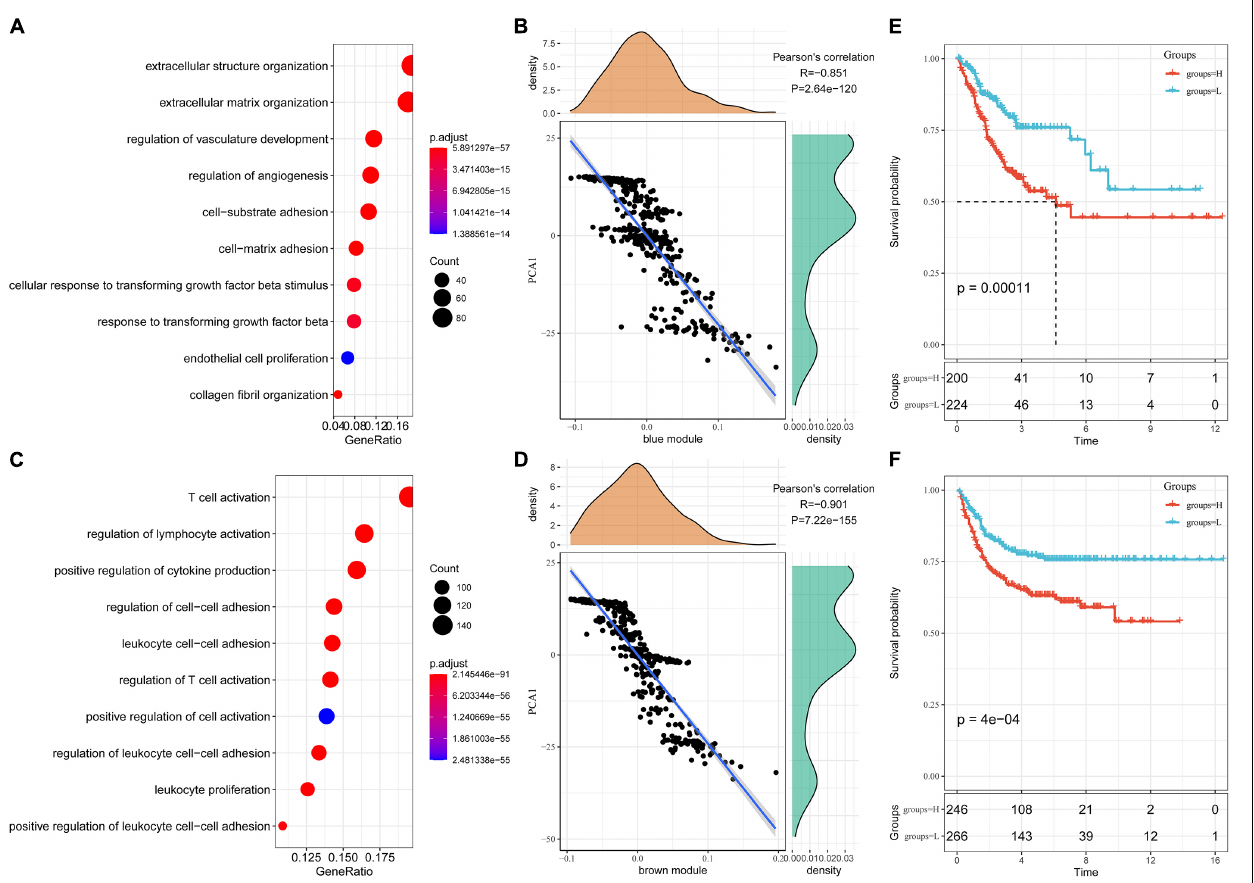
FIGURE 9 | The function and prognosis analysis of immune gene co-expressed genes. (A) Graphical results of gene enrichment analysis of genes in the blue module; (B) The correlation between the feature vector of the blue module and the first principal component in the immune landscape; (C) Graphical results of gene enrichment analysis of genes in the brown module; (D) The correlation between the feature vector of the brown module and the first principal component in the immune landscape; (E) Kaplan–Meier (KM) survival curve distribution of patients grouped according to the expression of model characteristic genes screened by the brown module in the TCGA-COAD cohort; (F) KM survival curve distribution of patients grouped according to the expression of model characteristic genes screened by the brown module in the GSE39582